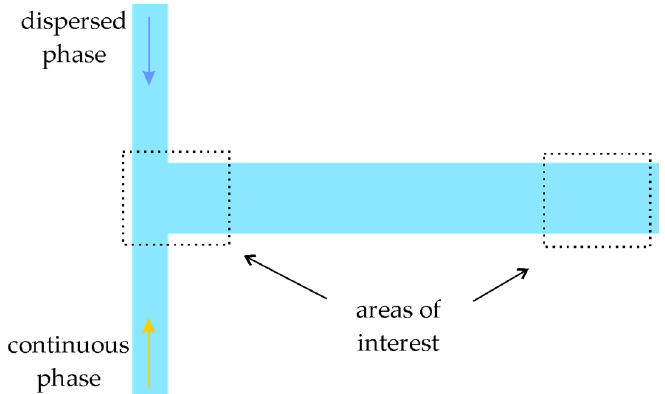
Figure 1. The scheme of the T-shaped microchannel.